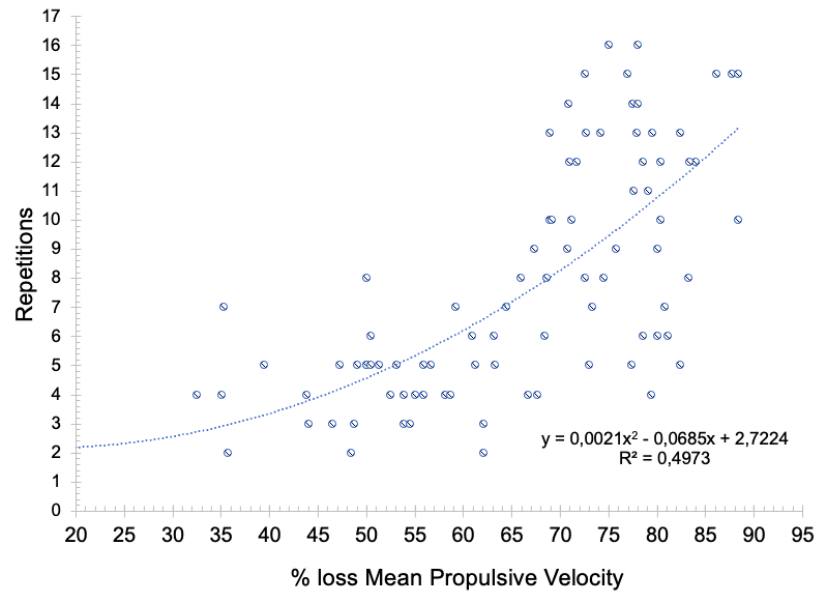
Figure 3. Linear regression between the number of repetitions performed and the velocity loss per- centage of each set of the exercise protocol.